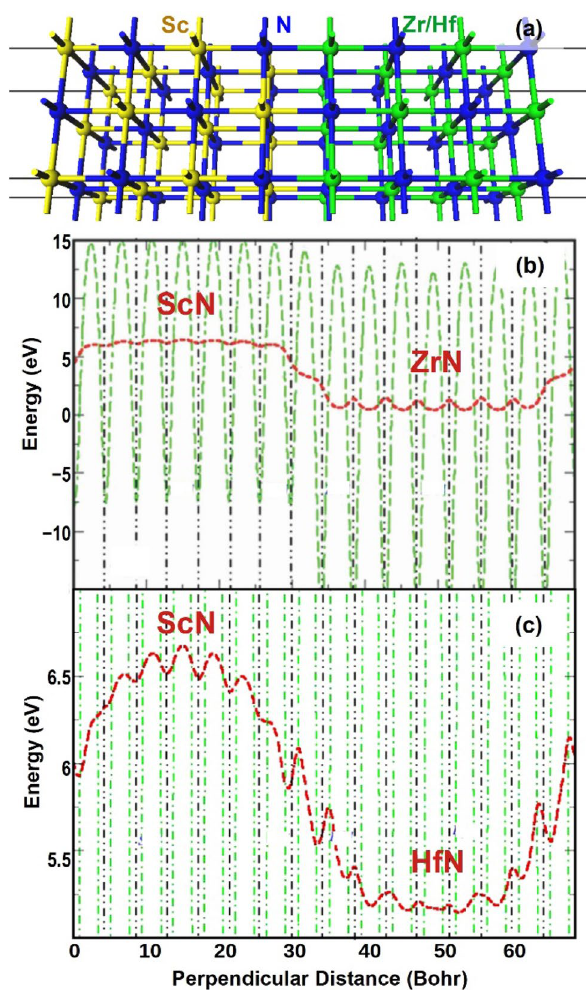
Fig. 12 a Metal–nitride interface structure formed between b ScN and ZrN [175] or c ScN and HfN [174]. b and c represent the pla- nar average electrostatic potential (green dashed line) as a function of perpendicular distance from the ScN/ZrN and ScN/HfN interfaces, respectively. The red dashed line indicates the lattice-plane oscilla- tions, which are filtered with the macroscopic averaging technique [182]. The vertical dashed black line represents the lattice planes. Adapted with permission from Refs.[174, 175]. Copyrights 2012 Institute of Physics and 2011 American Institute of